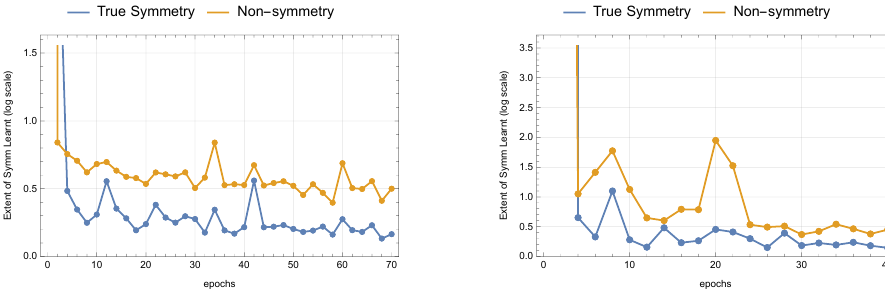
Figure 13 . Discrete isometries of the Fermat quintic defined in (8.5) being learnt. The plot shows the extent of learning given by (8.1) for the symmetry of the quintic surface described in (8.7). The plots correspond to two different networks trained in figure 9. We observe similar behavior for other symmetries of the class